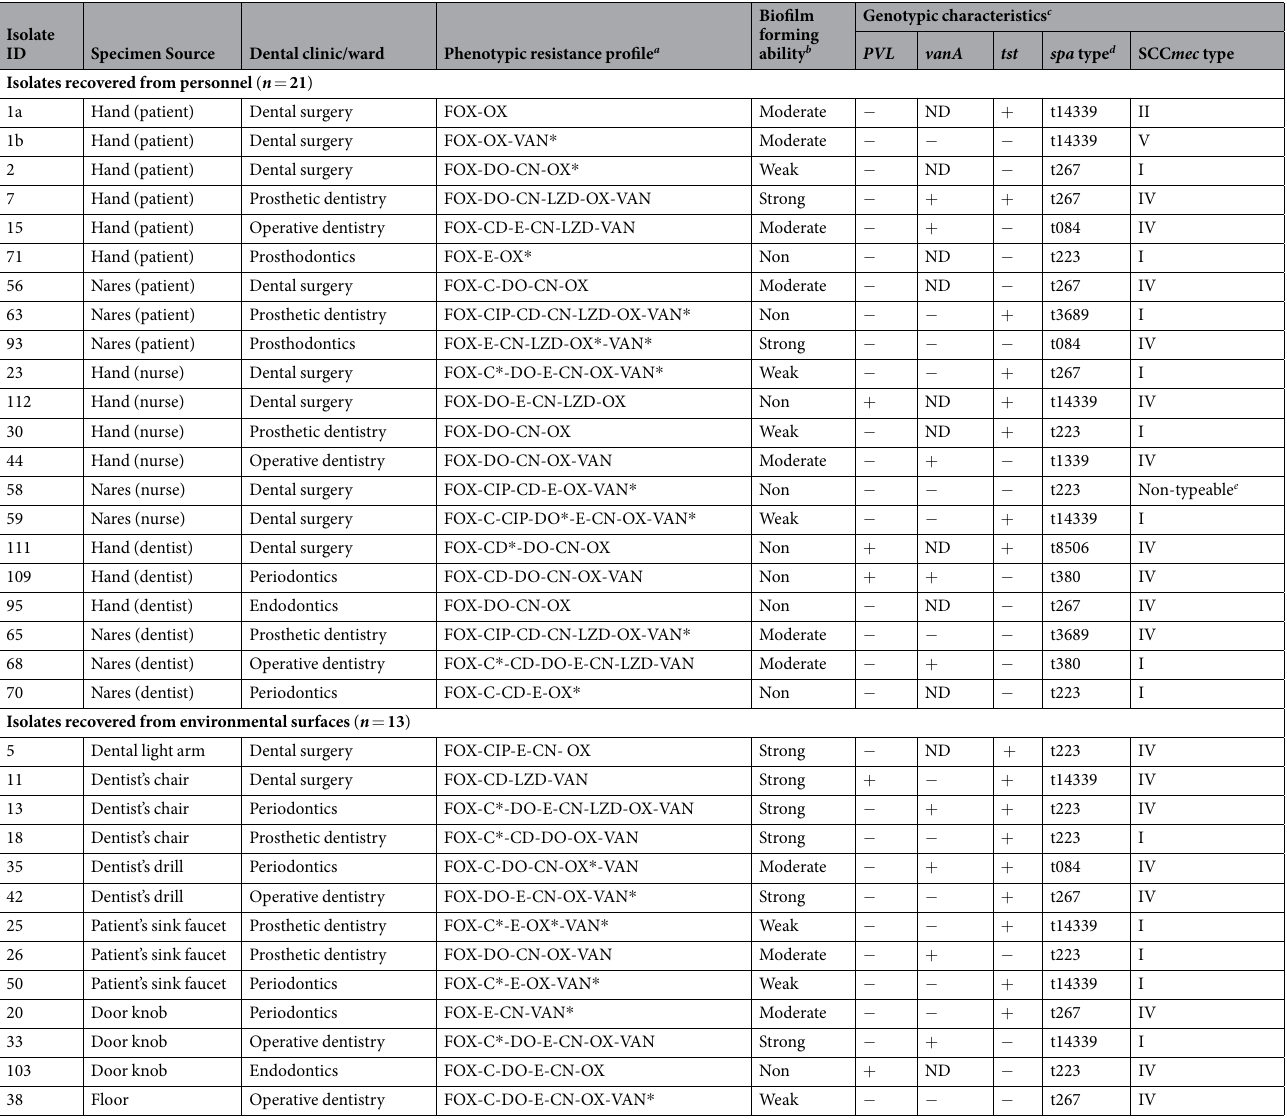
Table 2. Sources and characteristics of individual MRSA isolates ( n = 34) in this study. PVL : The gene encoding the Panton–Valentine leucocidin toxin; vanA: the gene encoding an enzyme that causes a structural change in the terminal amino acid of the pentapeptide chain of peptidoglycan, thus conferring vancomycin resistance; tst : the gene encoding the toxic shock syndrome toxin; spa: staphylococcal protein A; SCC mec : staphylococcal cassette chromosome mec ; a plus sign ( + ) denotes the presence of a gene; a minus sign ( − ) denotes the